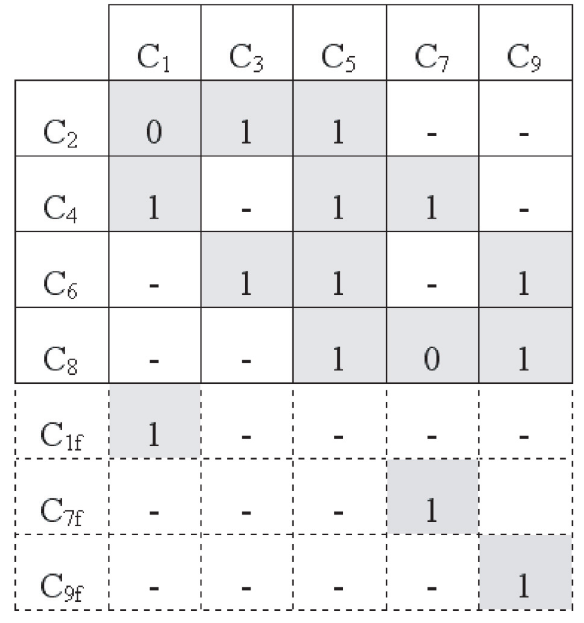
Fig. 3. Representation through adjacency matrix.